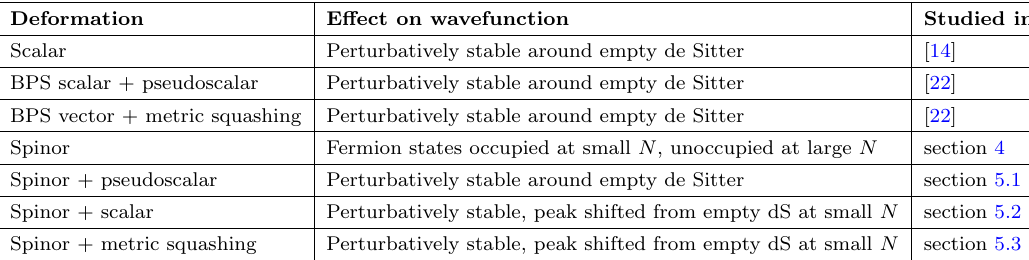
Table 1 . Summary of for which bulk (cid:12)elds the wavefunction of the N = 2 supersymmetric higher spin theory has been computed using dS/CFT. The pseudoscalar (cid:12)eld or squashing by itself in the SUSY model have not been given a detailed discussion, but its behaviour can easily be seen by setting (cid:12) = 1 in the relevant